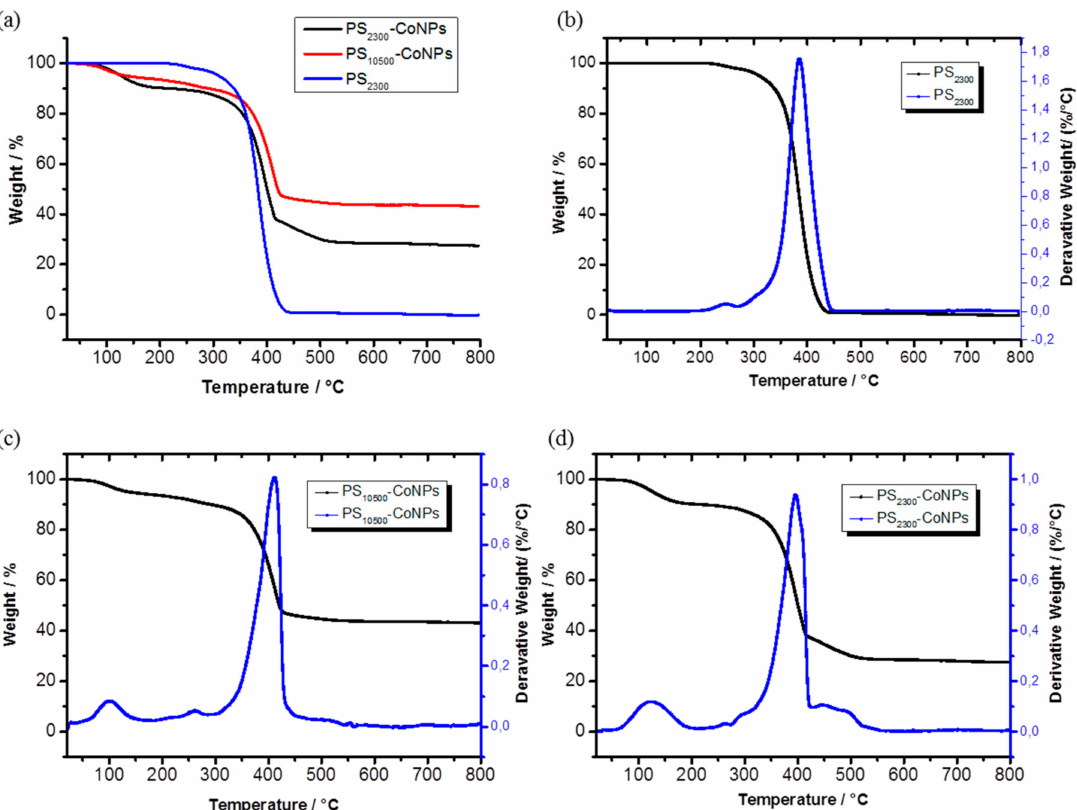
Figure 9. TGA analysis: ( a ) overview profile of PS 2300 –Co NPs, PS 10500 –Co NPs and free PS–NH 2 ( M n = 2300 g/mol); ( b ) free PS–NH 2 ( M n = 2300 g/mol); ( c ) PS 10500 –Co NPs; ( d ) PS 2300 –Co NPs. The black lines indicate the percent weight as a function of temperature and the weight loss derivative is shown in